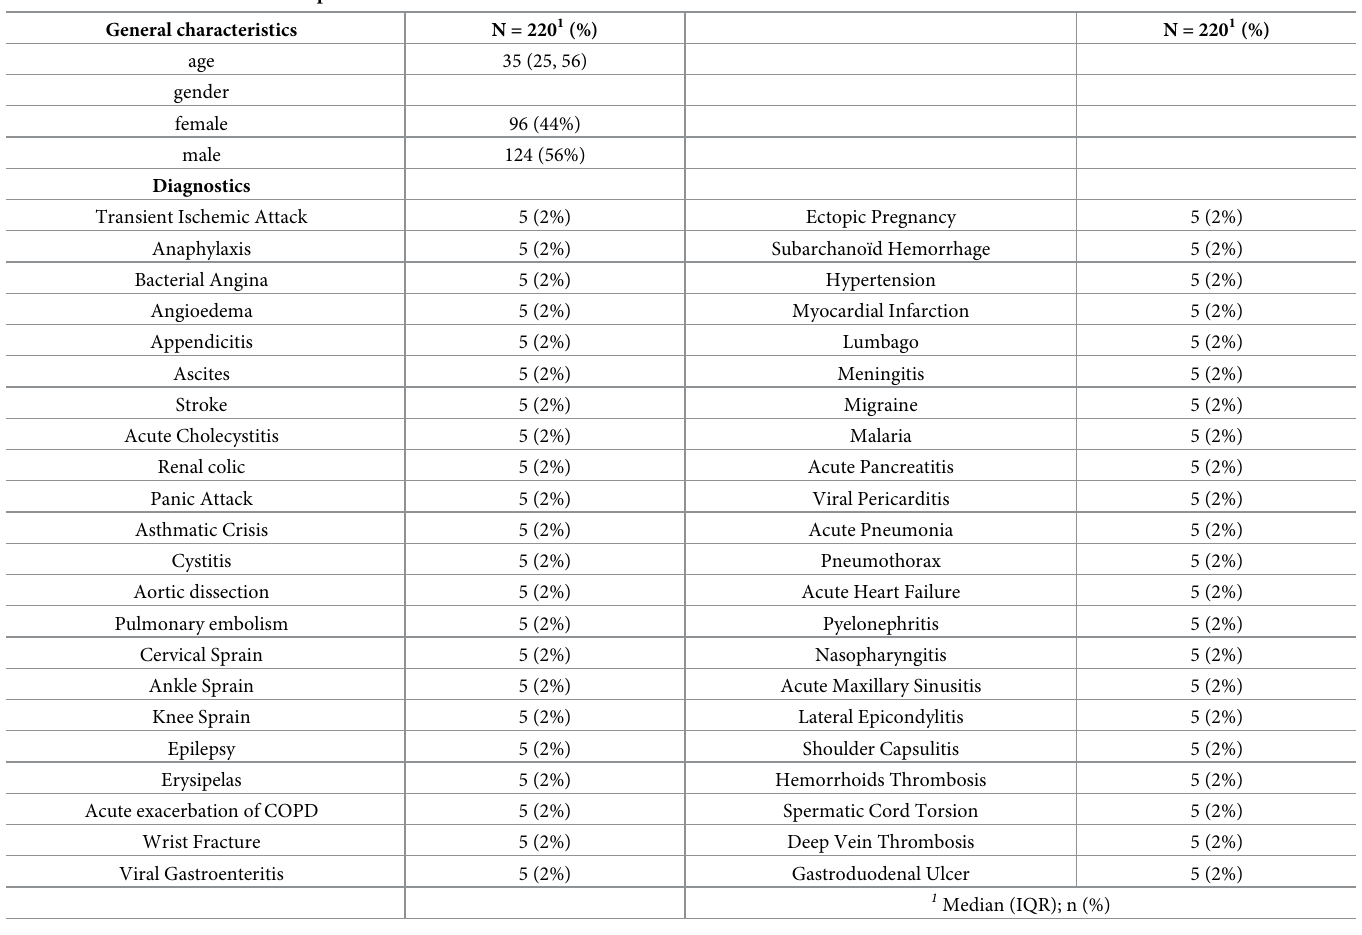
Table 1. Characteristics of simulated patients.